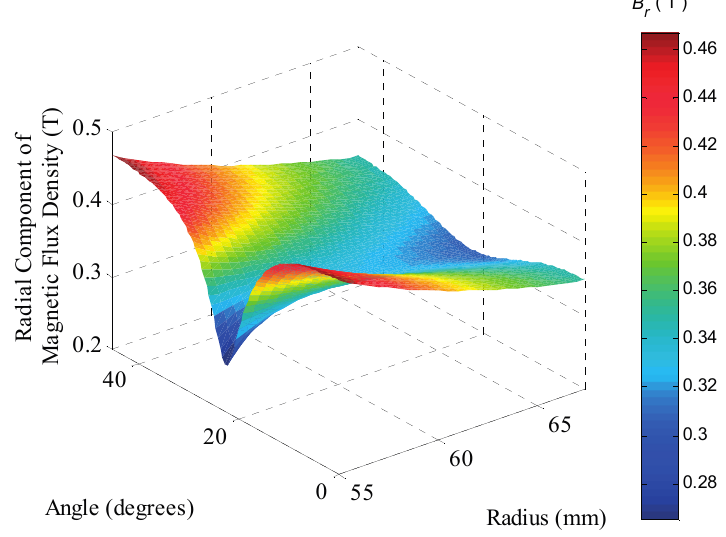
Figure 8. Radial component of magnetic flux density in the region of the coils at an axial section located at τ /2 of the actuator with eight segments of parallel magnetization. m